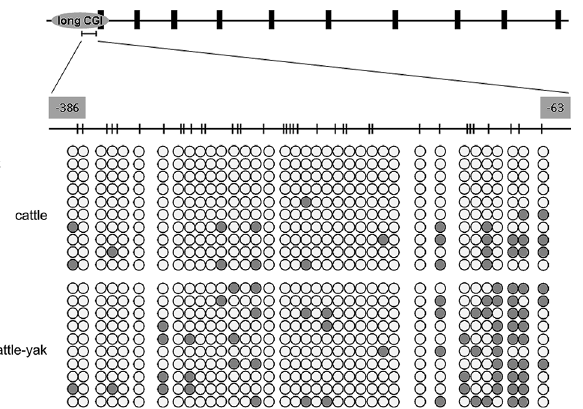
Fig 1. The methylation profile of the long CpG island in the b Boule 5' flanking region. (A) Schematic diagram of the long CGI within the b Boule promoter. (B) Schematic depiction of the CpG sites for methylation analysis. Nucleotide numbering is relative to +1 at the initiating ATG codon. The short vertical bars represent the CpG dinucleotides. (C) Methylation status of the b Boule promoter in the testes of cattle and cattle-yak hybrids. Each line represents an individual bacterial clone that was sequenced. Open circles indicate unmethylated CpG sites. Black circles indicate methylated CpG sites.